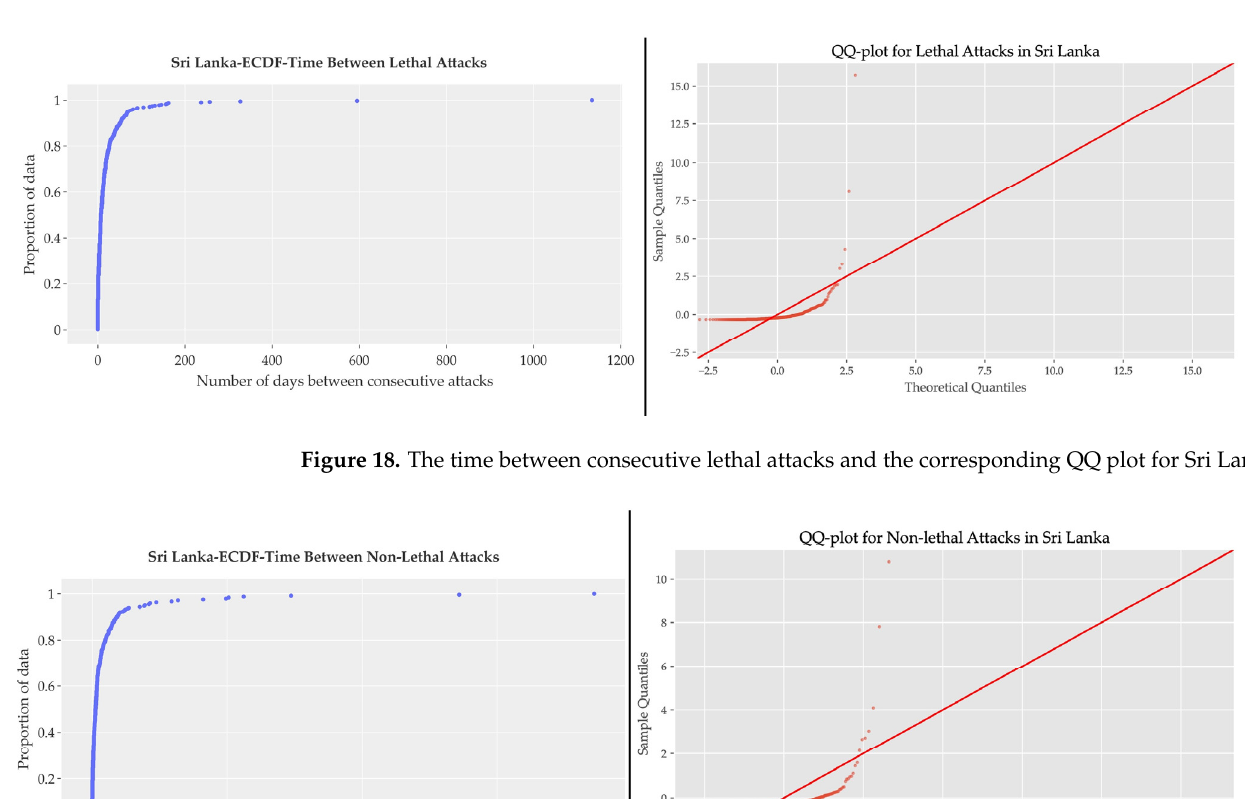
ISPRS Int. J. Geo-Inf. 2023 , 12 , x FOR PEER REVIEW